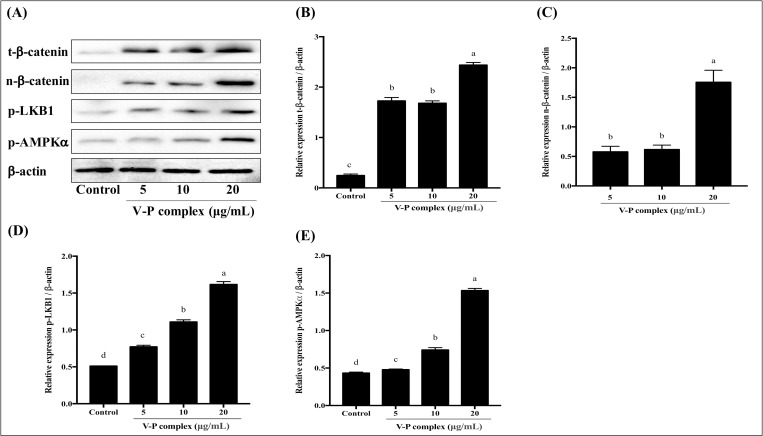
Effect of V-P complex on the protein expression.a, b, c, d Different letters indicate a significant difference (p< 0.05) within the graph.